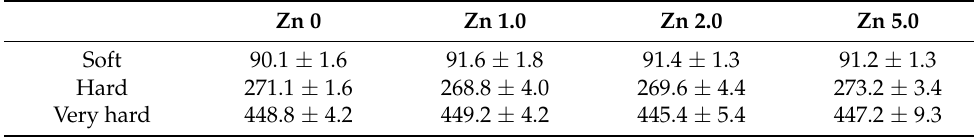
Table 2. Water hardness (CaCO 3 mg/L) during the